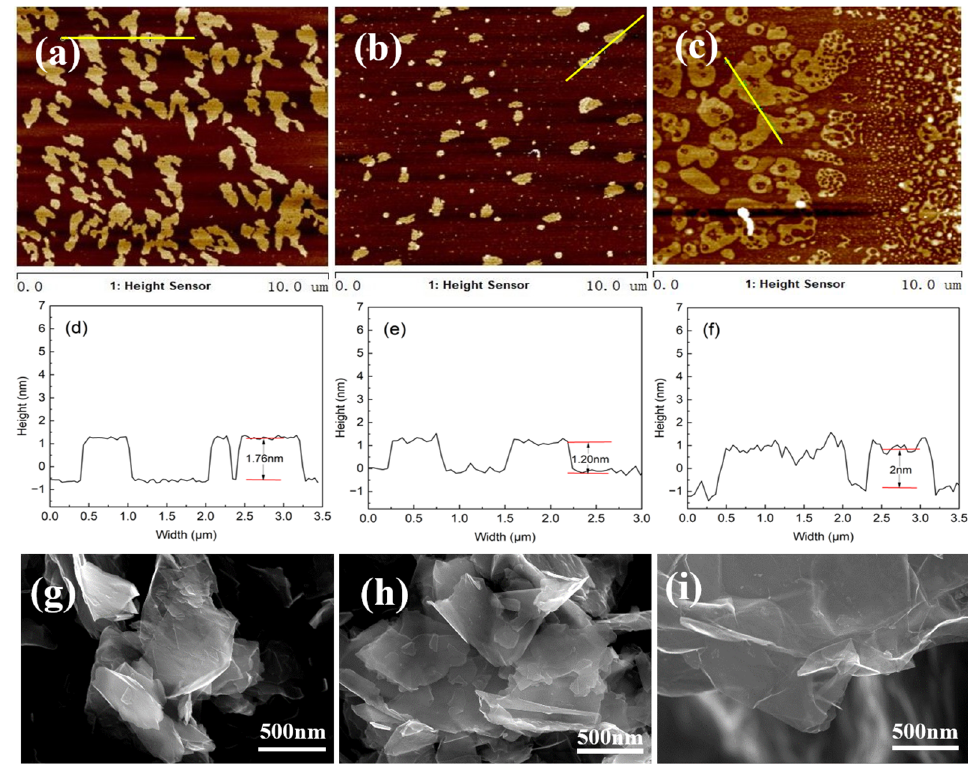
Figure 2. AFM 2D images of graphene ( a ) G1, ( b ) G2, and ( c ) rGO; the thickness (height) of graphene ( d ) G1, ( e ) G2, and ( f ) rGO; and FESEM images of graphene ( g ) G1, ( h ) G2, and ( i ) rGO.